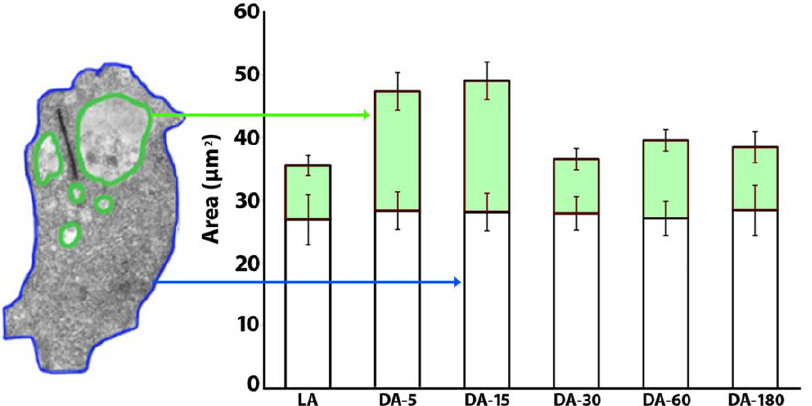
Figure 4. Changes in surface area. The histogram shows changes in the surface area of rod spherules and horizontal cell endings and bipolar cell dendrites (blue and green lines, left side) in the light (LA) and the dark (DA). The x-axis plots the time in minutes and the y-axis, the surface area in m m 2 . The surface area of the axon terminal did not change significantly (white rectangles). In contrast, the surface area of the horizontal and bipolar cell endings increased in mice left for 3–5 and 15 minutes in the dark (green rectangle). After 30 minutes in the dark, the horizontal endings returned to the same size as horizontal cell endings in the light, and they remained in the same size range up to 180 minutes in the dark. doi:10.1371/journal.pone.0016944.g004 PLoS ONE |